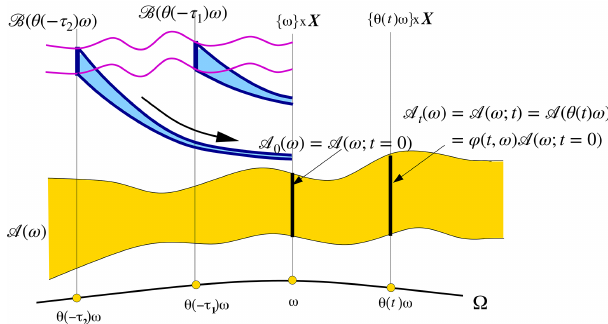
Figure 7. Schematic diagram of a random attractor ( ω ) and of the pullback attraction to it; here ω labels the particular realization of the random process θ ( t ) ω that drives the system. We illustrate the evolution in time t of the random process θ ( t ) ω (light solid black line at the bottom), the random attractor ( ω ) itself (yel- low band in the middle), with the snapshots A 0 ( ω ) = A ( ω ; t = 0)) and A ( ω ; t ) (the two vertical sections, heavy solid lines), and the flow of an arbitrary compact set B from “pullback times” t = − τ 2 and t = − τ 1 onto the attractor (heavy blue arrows). See Ghil et al. (2008, Appendix A) for the requisite properties of the random pro- cess θ ( t ) ω that drives the RDS formulated by Eq. (20). Adapted from Physica D: Nonlinear Phenomena, 237, Ghil et al. (2008), Cli- mate dynamics and fluid mechanics: natural variability and related uncertainties, 2111–2126, © 2008 Elsevier B.V. All rights reserved. 2008, with permission from